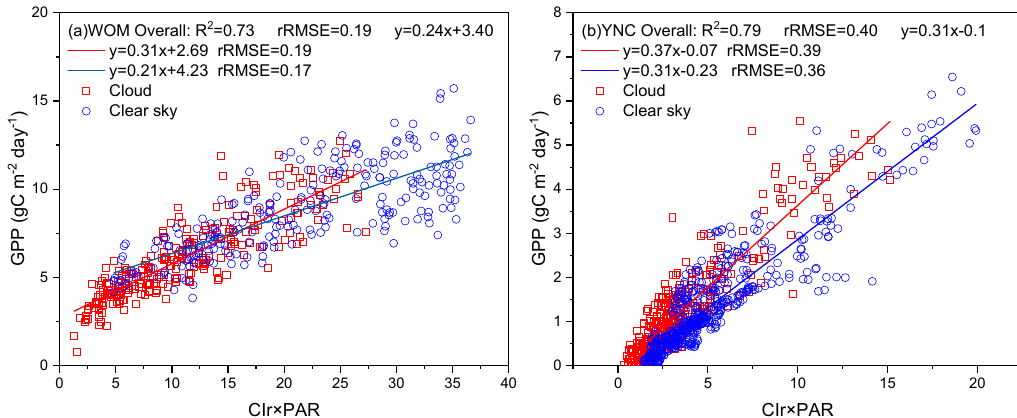
Figure 5. The relationship between daily GPP CIr and GPP EC under different percentages of cloud cover. The dates with daily clear sky index (CSI) > 0.8 (blue circles) are defined as clear days, whereas CSI < 0.8 (red squares) indicates cloudy days.